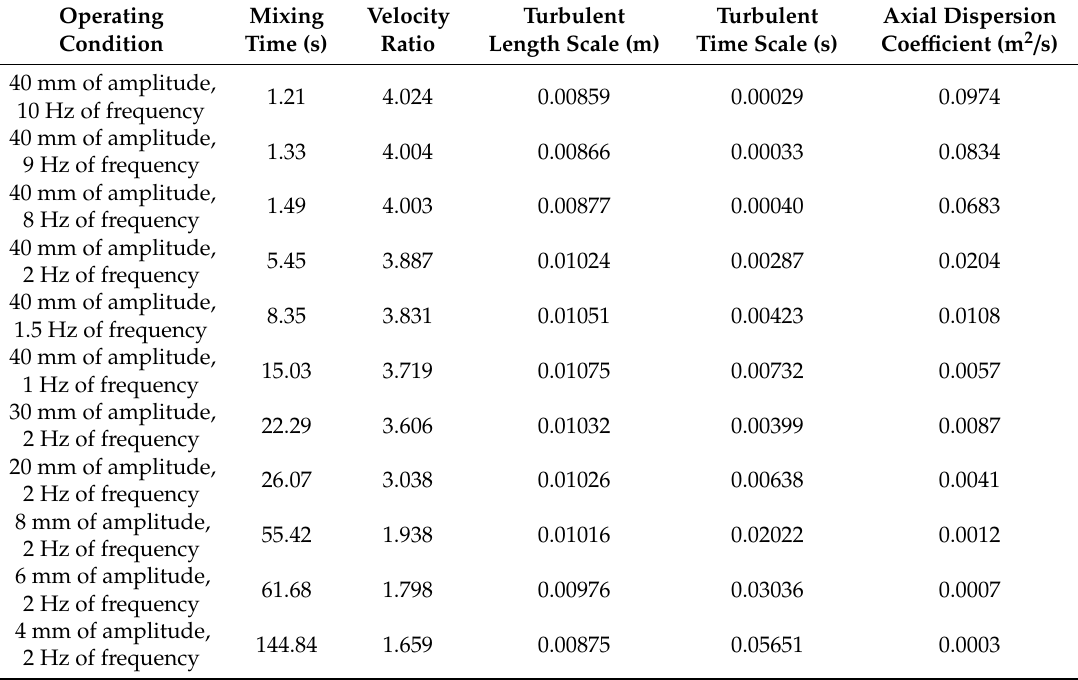
Table 4. The values of mixing indices in di ff erent operating